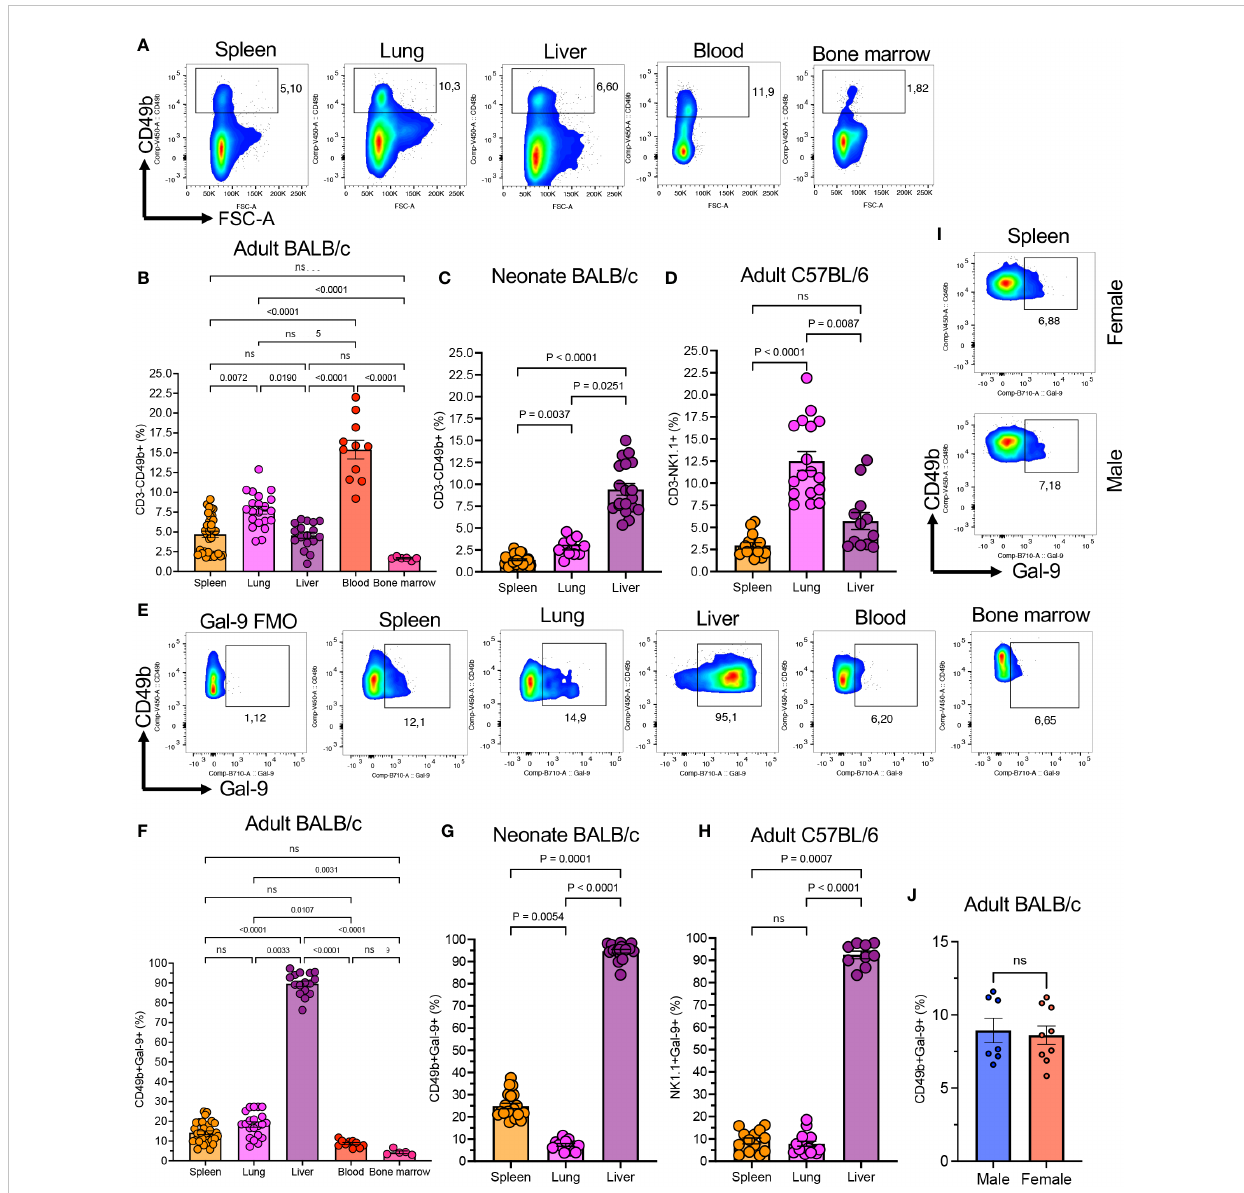
FIGURE 1 The presence of Gal-9 + NK cells in different compartments in mice. (A) Representative fl ow cytometry plots showing percentages of total and Gal- 9 + NK cells in the spleen, lung, liver, blood, and bone marrow of adult BALB/c mice. (B) Cumulative data of the percentages of NK cells in indicated compartments in adult BALB/c, (C) neonatal (day 7-old) BALB/c, and (D) adult C57BL/6 mice. (E) Representative fl ow cytometry data of percent Gal- 9 + NK cells in different compartments. (F) Cumulative data of percentages of Gal-9 + NK cells in indicated compartments in adult BALB/c, (G) neonatal BALB/c, and (H) adult C57BL/6 mice. (I) Representative fl ow plots, and (J) cumulative data of percentages of Gal-9 + NK cells in the spleen of male and female BALB/c mice. Each dot represents data from an animal, mean ± SEM from multiple independent experiments. Fluorescence minus one (FMO), not signi fi cant